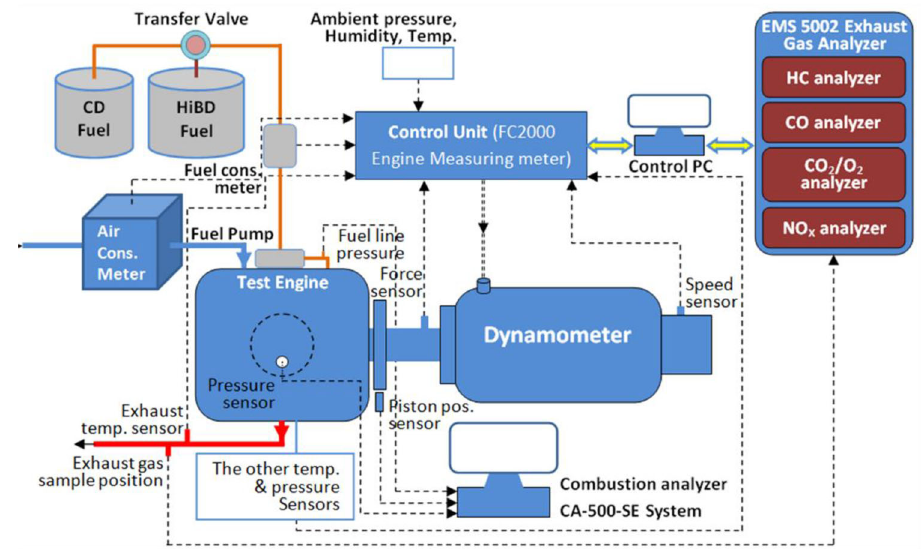
Fig. 2 Schematic diagram of the engine testbed and completed engine testbed in the experiment